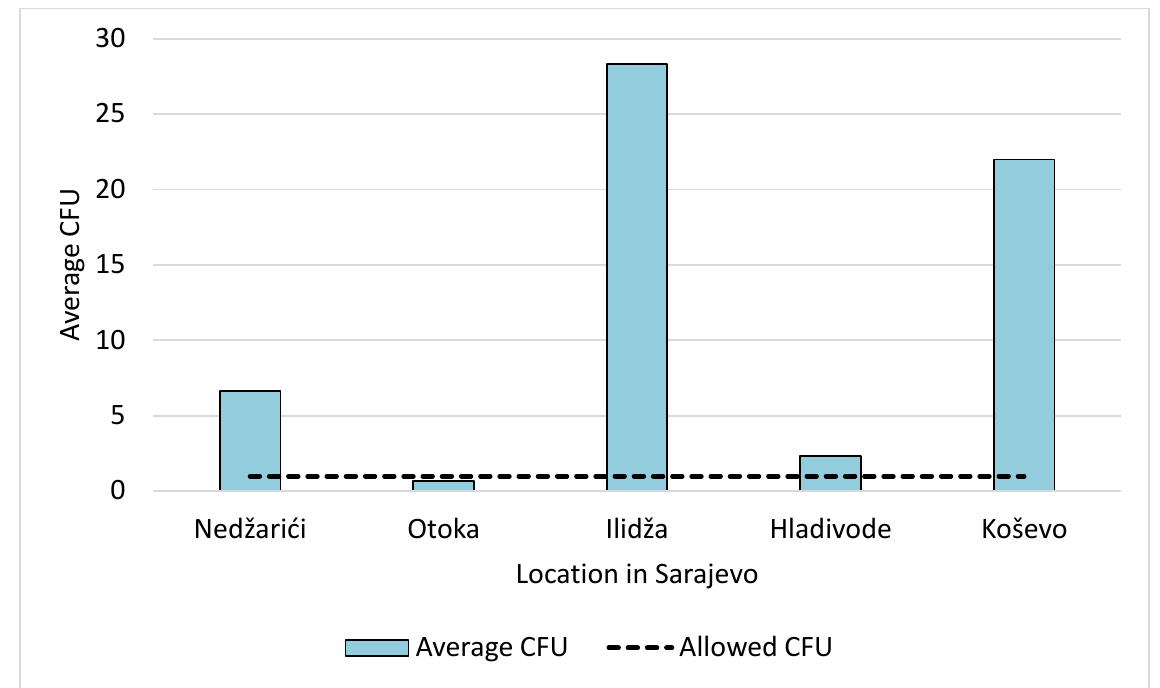
Figure 1. Average CFU compared to the standard CFU